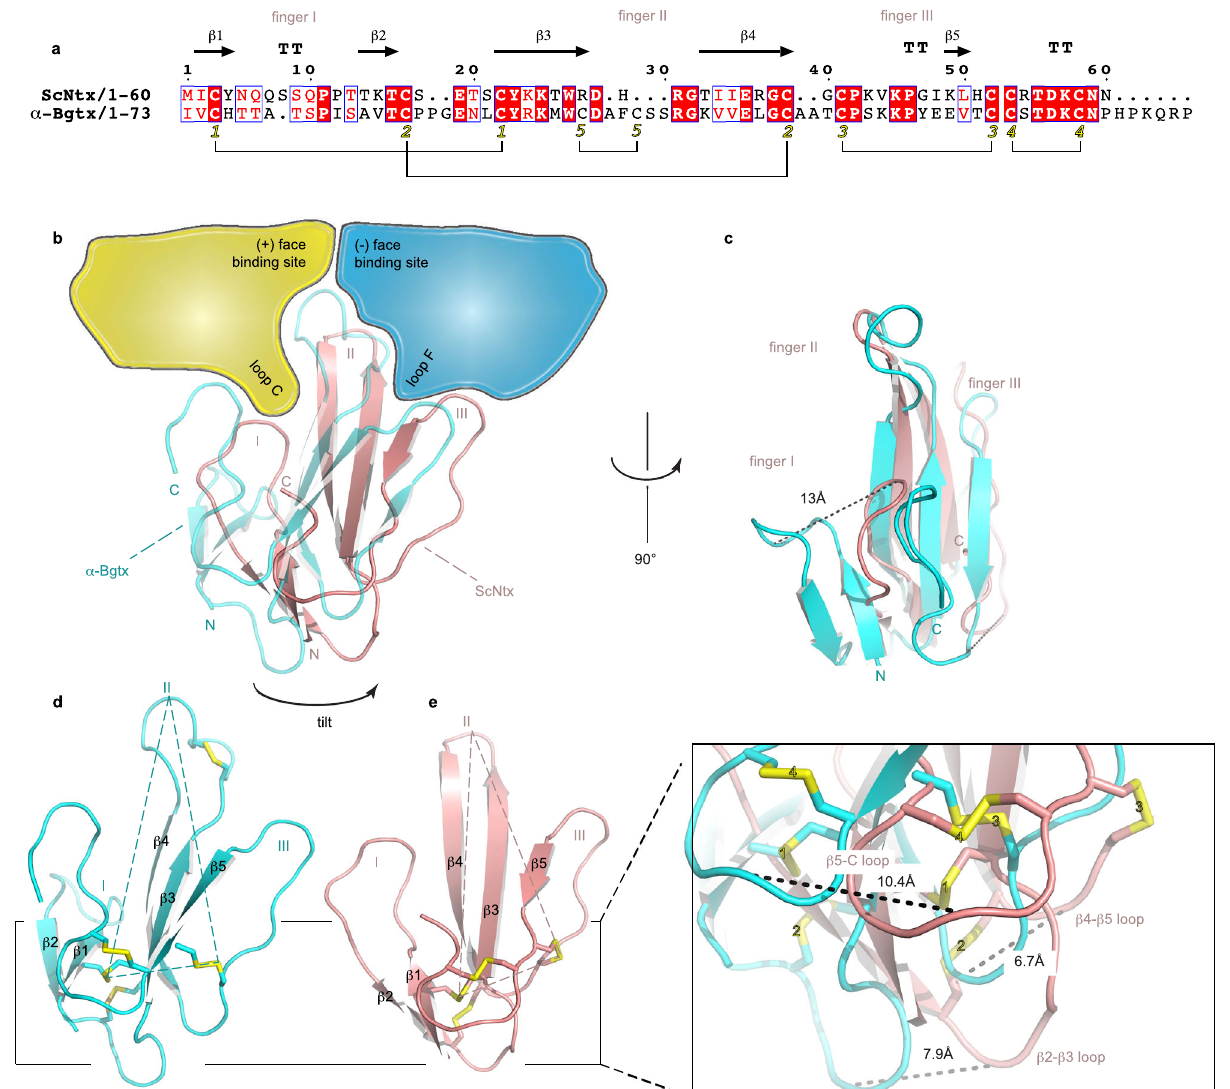
Fig. 2 | Comparison of the ScNtx and α -Bgtx binding mode to the Torpedo nAChR.a SequencealignmentofScNtxand α -BgtxgeneratedinESPRIPT 54 .Residue numbering and secondary structure information at the top is for ScNtx. TT indi- cates a β -turn. Yellow digits indicate disul fi de bonds. Blue frames indicate regions of similarity. Red boxes indicate strict conservation, red characters indicate simi- larity. b , c Differences in binding mode of ScNtx (salmon) and α -Bgtx (cyan) at the α - δ subunit interface after superposition of the ScNtx- Torpedo nAChR complex onto the α -Bgtx- Torpedo nAChR complex (PDB ID: 6UWZ 14 ). The principal subunit ( α δ ) is shown in yellow; the complementary subunit ( δ ) is shown in blue. The